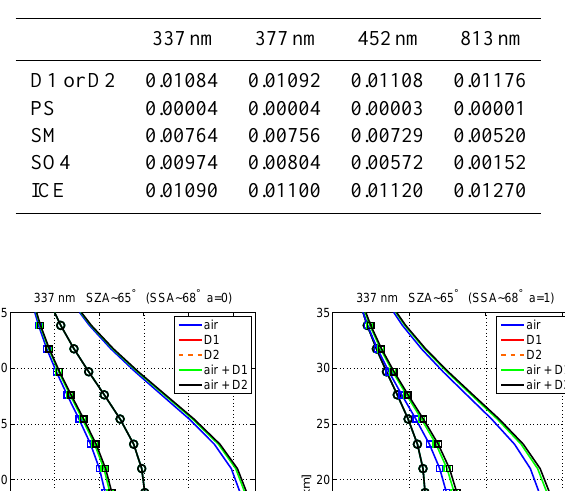
Table 5. Calculated size parameters ( x = 2 πr/λ ) as a function of wavelength and particle